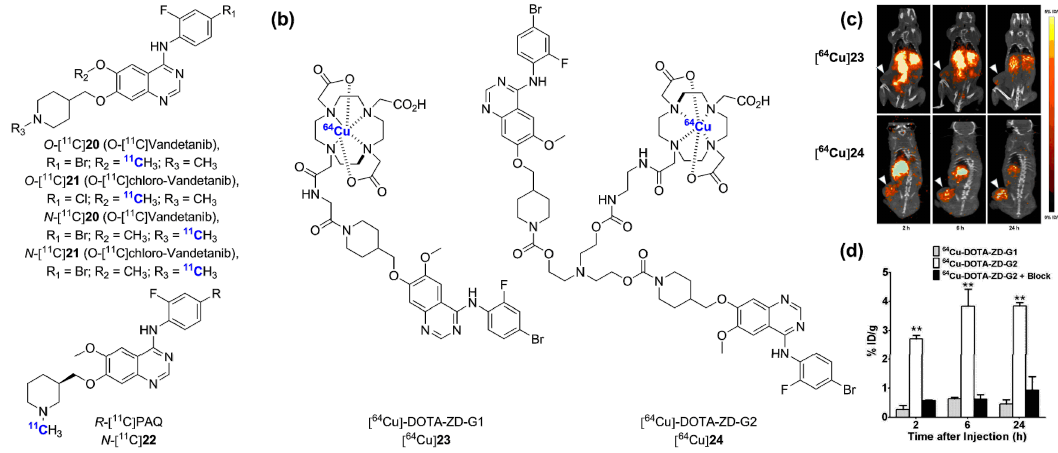
Figure 8. VEGFRs targeted radiotracers. ( a ) Chemical structures of radiolabeled inhibitors primarily targeting VEGFRs: [ 11 C]vandetanib, [ 11 C]chloro-vandetanib and R -[ 11 C]PAQ; ( b ) Chemical structures of vandetanib-derivatized 64 Cu-labeled monomeric ([ 64 Cu] 23 ) and dimeric ([ 64 Cu]24) radiolabeled inhibitors; ( c ) Coronal PET/CT images of inhibitors [ 64 Cu] 23 and [ 64 Cu] 24 in U-87 tumor bearing mice and ( d ) corresponding quantitative analysis. ** p < 0.0001 (this research was originally published in [111] © the Society of Nuclear Medicine and Molecular Imaging, Inc.).